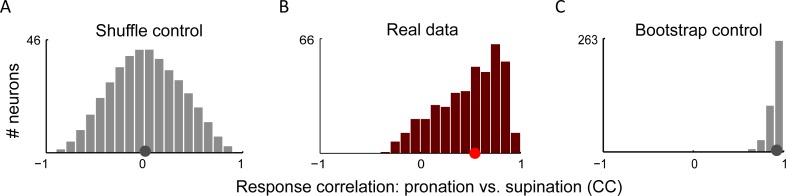
A. Distribution of correlation coefficients between pronation and supination for shuffle control, created by computing correlation coefficient between each pronation response function and supination response of 1,000 other neurons (with replacement), median = 0. B. Same for responses of real (tuned) neurons, median = 0.54. C. Same, for a bootstrap control, median = 0.93, drastically different than for real data (Bootstrap of the medians, p < 10−64).